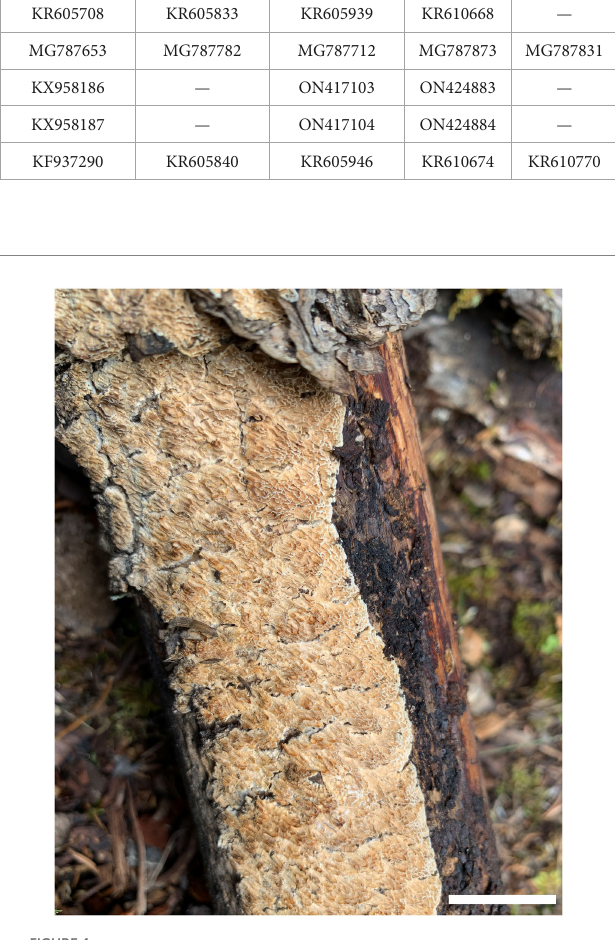
FIGURE 4 Basidiocarp of Antrodia variispora (holotype, Dai 23995). Scale bar: 2 cm.